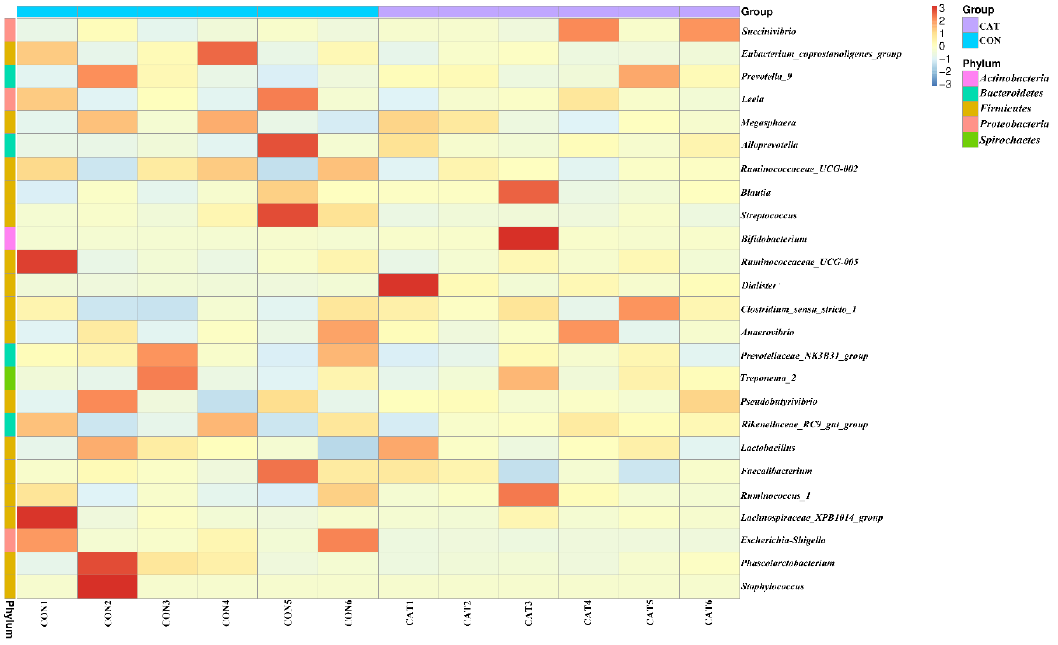
Figure 5. Bacterial community heatmap analysis at the genus level. CON 1, 2, 3, 4, 5, and 6 are colonic digesta samples from piglets fed with a basal diet; CAT 1, 2, 3, 4, 5, and 6 are colonic digesta samples from piglets fed with a basal diet supplemented with 2.0 g/kg exogenous catalase production.